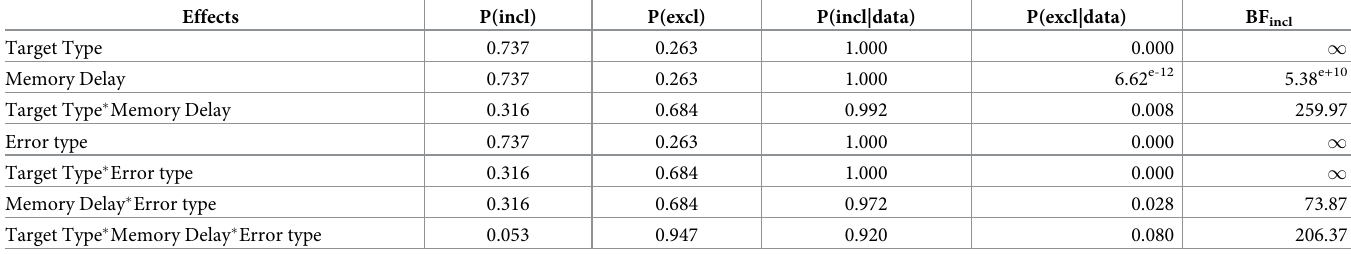
and Table 3 for an overview of BFincl for each model component). Pseudo-letter targets were more likely to evoke memory illusions than real-letter targets (BFincl > 1000 for Target type), Table 2. Error rates